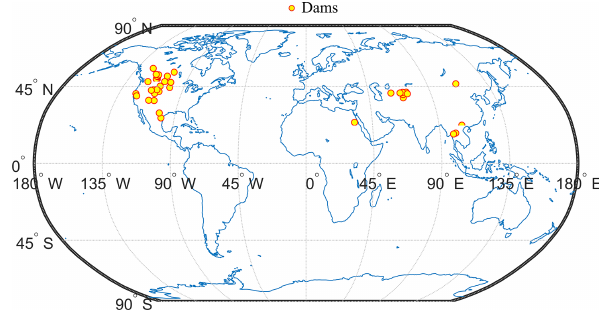
Figure 3. Locations of dams used to evaluate the reservoir routing